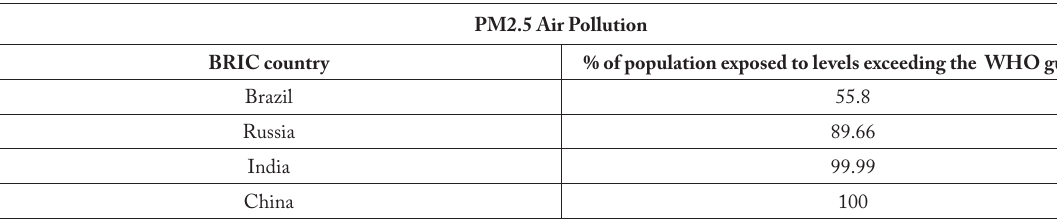
Table 6. Population living in areas where PM2.5 levels exceed the WHO guideline set value in 2015-2016 [62].